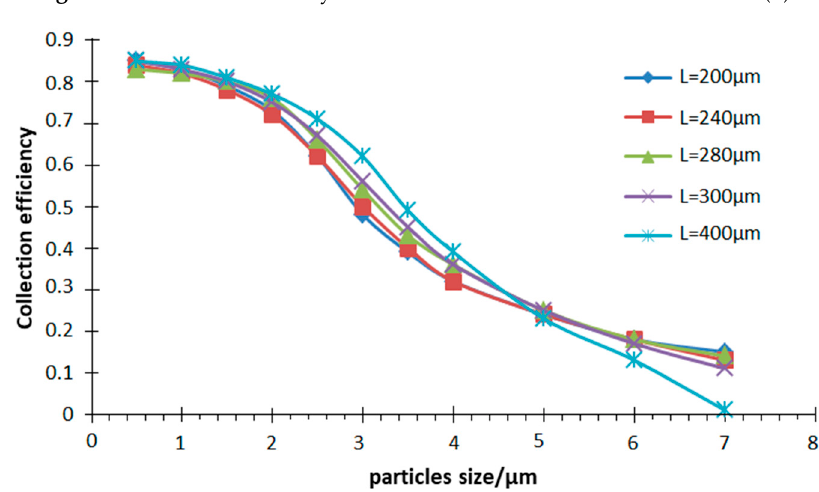
Figure 5. Collection e ffi ciency curve with di ff erent main flow width ( L ).